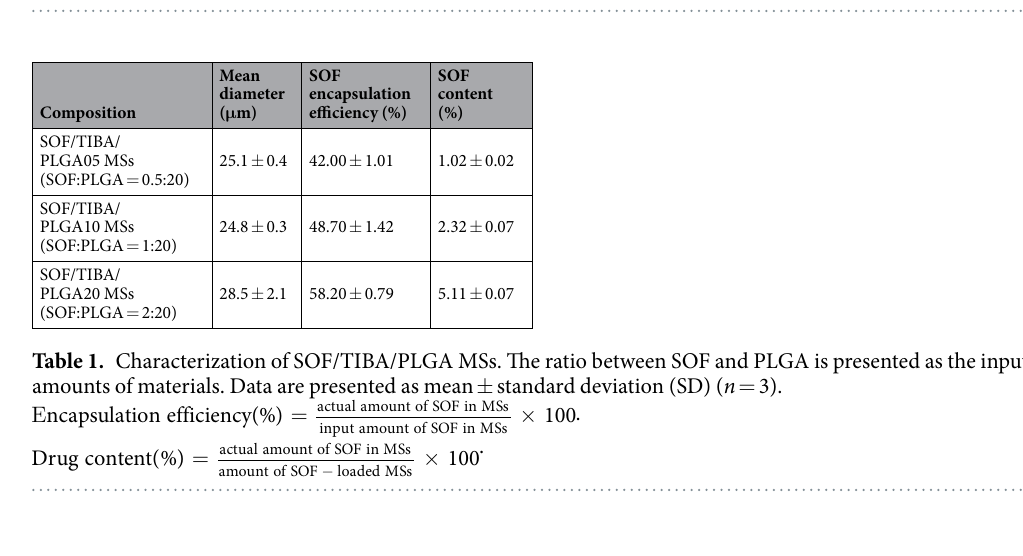
Figure 1. Schematic illustrations of developed MSs. ( A ) Fabrication process of SOF/TIBA/PLGA MSs is shown. ( B ) Therapeutic and imaging strategies of SOF/TIBA/PLGA MSs are presented. It is based on the illustration of the literature 28 and permission was acquired from the publisher for its reuse.